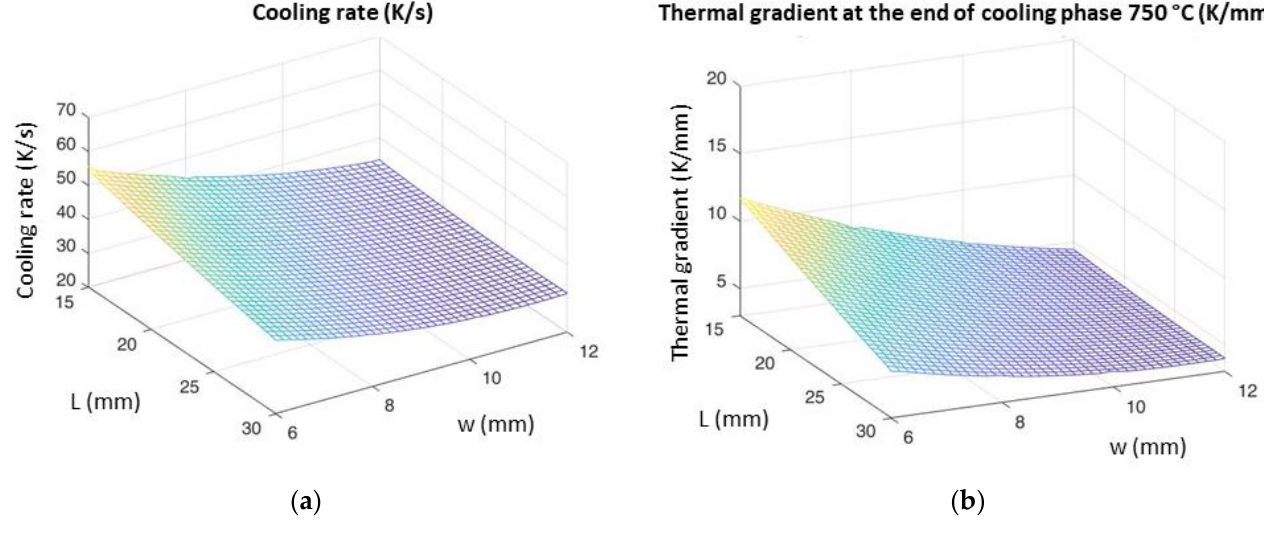
Figure 6. Metamodels for the USIBOR ® 1500 of ( a ) the cooling rate from the complete austenitization temperature (930 °C) to the test temperature (750 °C) and ( b ) the thermal gradient at the test temperature (750 °C) before the deformation phase as a function of L and w.